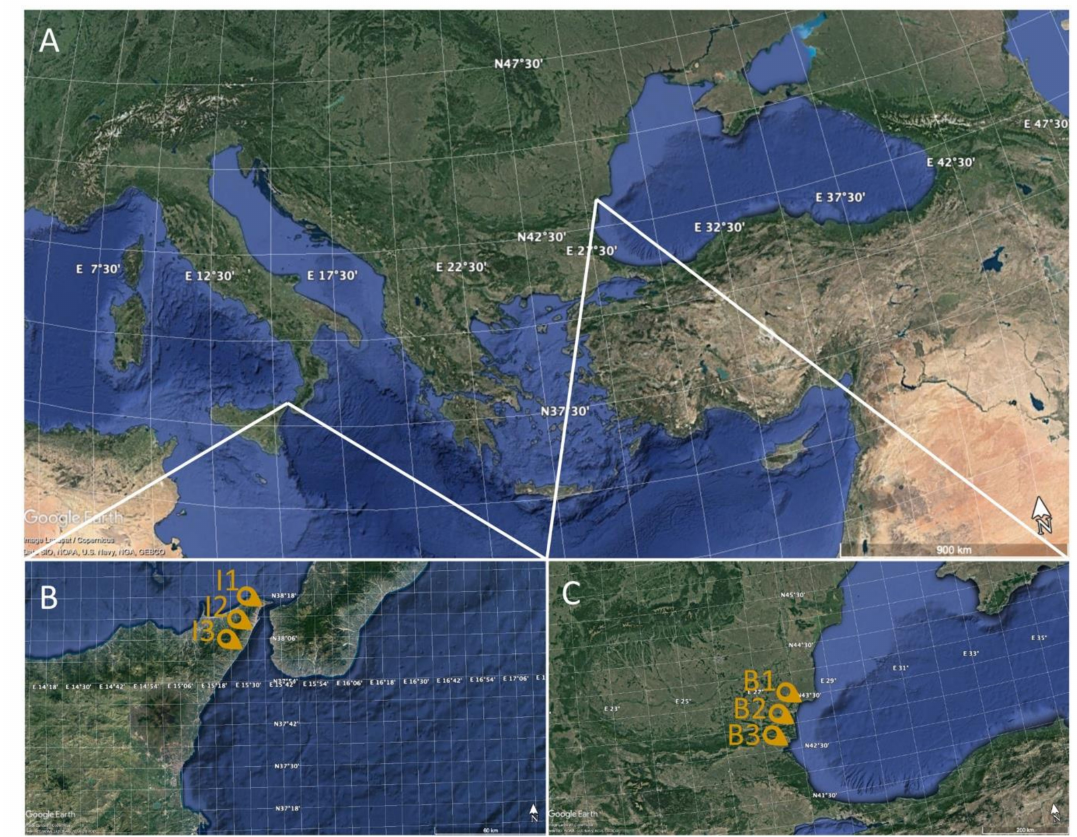
Figure 1. Maps indicating di ff erent sampling points. ( A ) Central-eastern Mediterranean Sea. ( B ) Ionian Sea (Italy) (sampling stations I1, I2, T3), ( C ) Black Sea (Bulgaria) (sampling stations B1, B2,